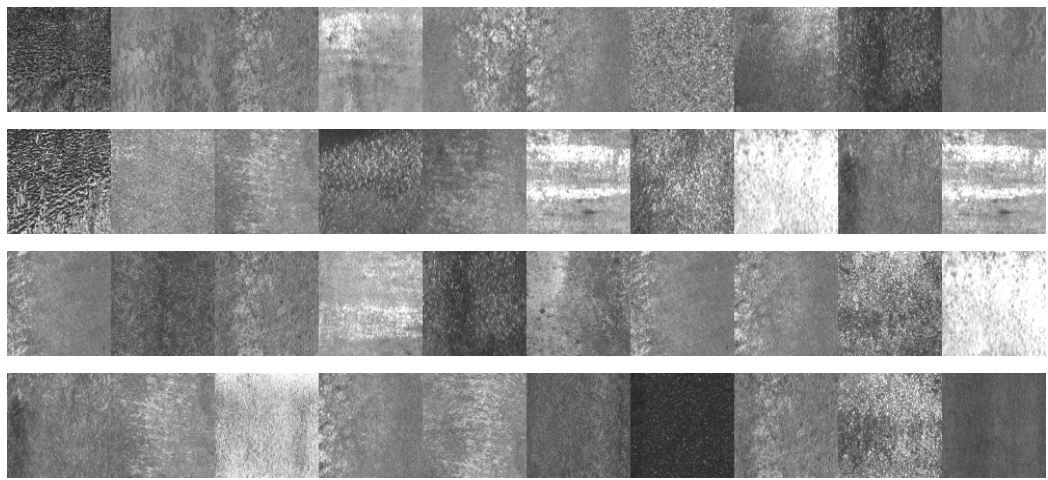
Figure 5. Negative